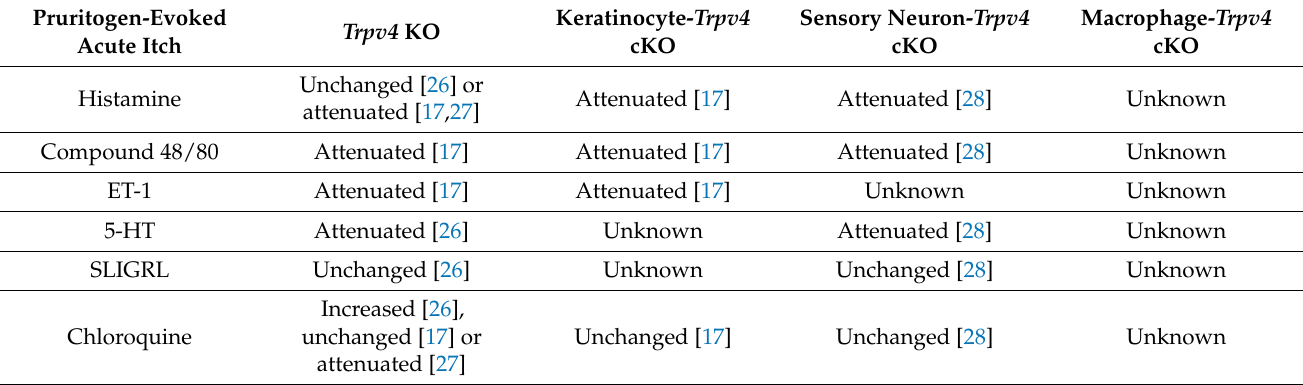
Table 1. Effects of global or conditional knockout of Trpv4 on pruritogen-induced acute itch behaviors.